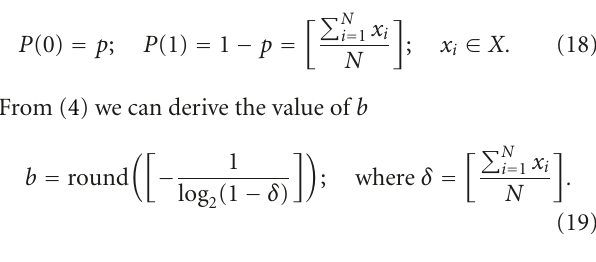
as the lower bound. The optimized values are saved after the current distortion is higher than the previous one or the number of vectors has exceeded the maximum